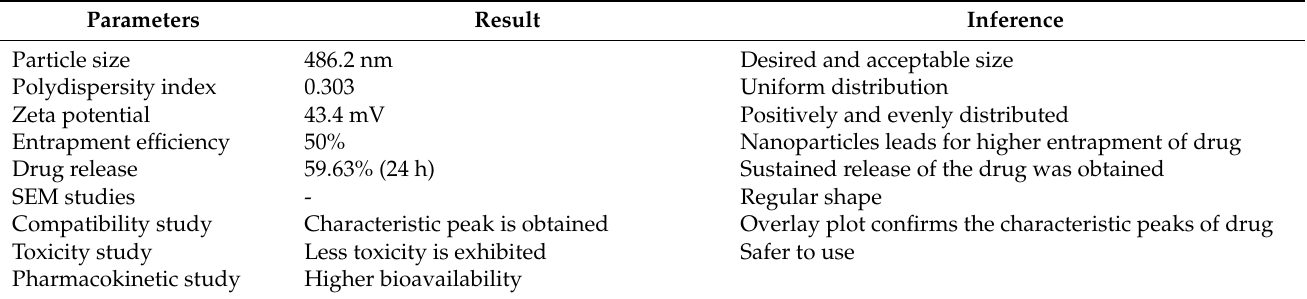
Table 5. Concluding features of experimental work for optimized